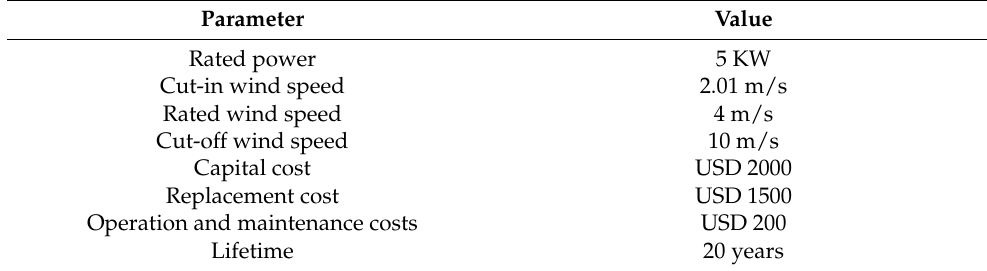
Table 1. Technical parameters for the RC-5K-A turbine.